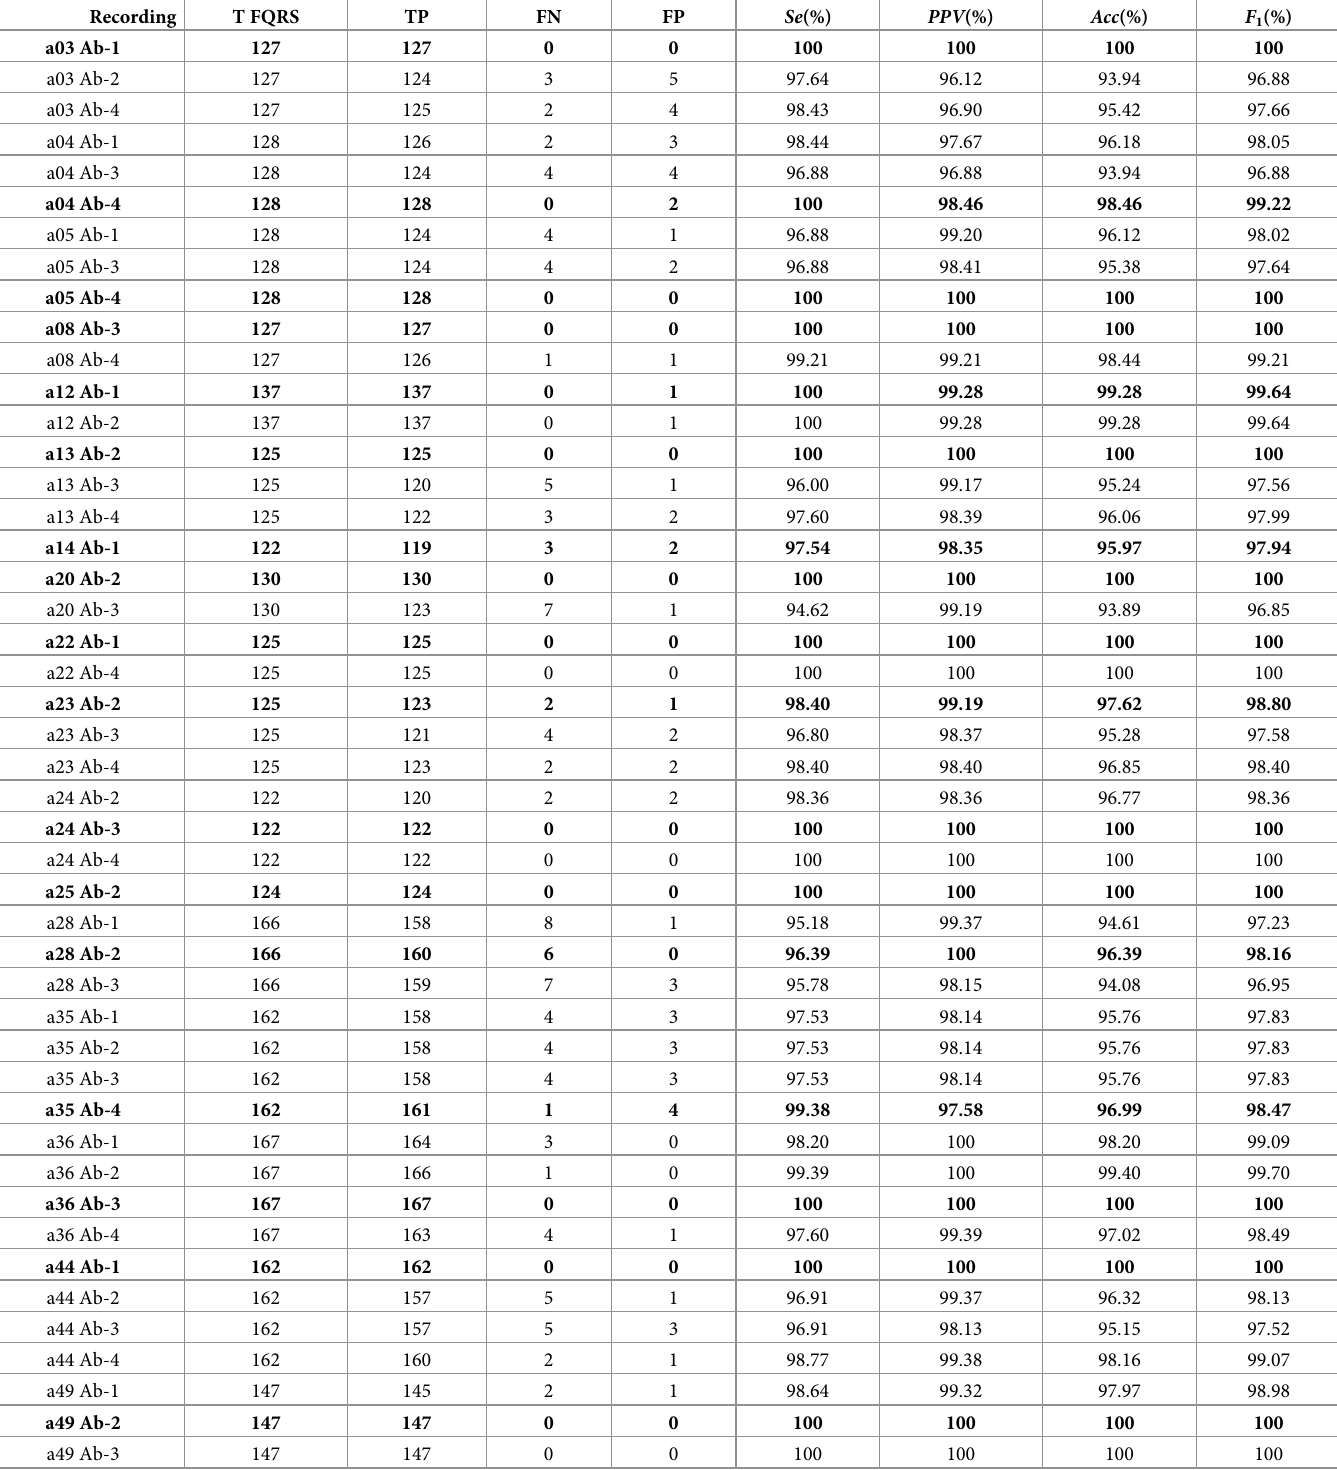
Table 2. Evaluation results using Challenge 2013 Training SetA 1-minute recordings as testing data (data for the best performing channel in each recording are shown in bold